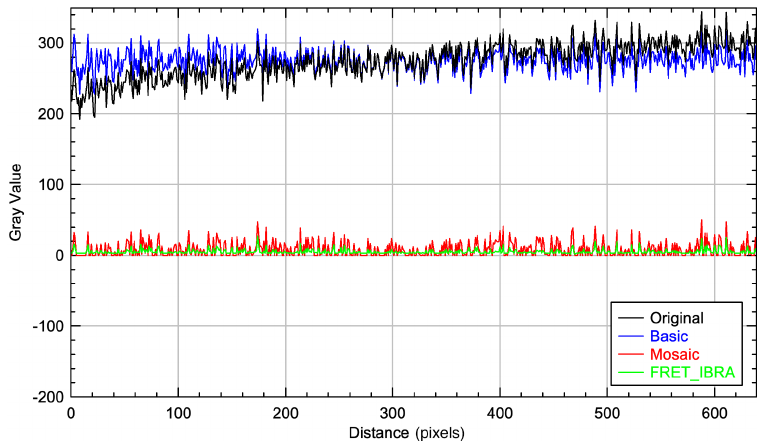
Fig 3. Background subtraction comparison. Background levels according to dashed line 2 in Fig 2 after background subtraction with FRET-IBRA, BaSiC, and Mosaic compared with the original image. The BaSiC plugin corrected only the shading, while Mosaic and FRET-IBRA corrected the shading and subtracted the background. Overall, processing the image with FRET-IBRA results in the background with the lowest pixel intensity and standard deviation.